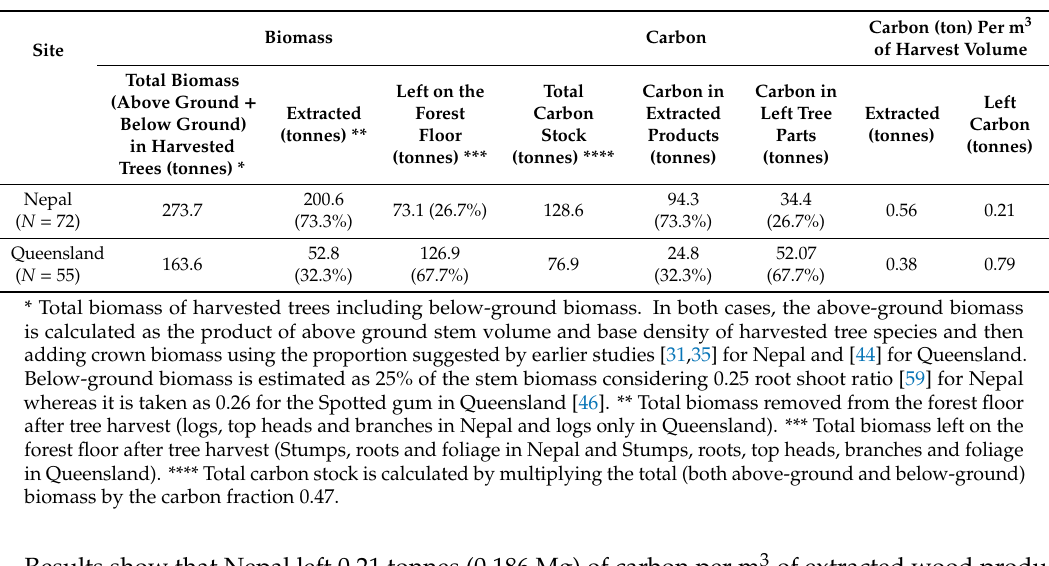
Table 5. Total stock, extracted and left biomass and carbon in Nepal and old sites.